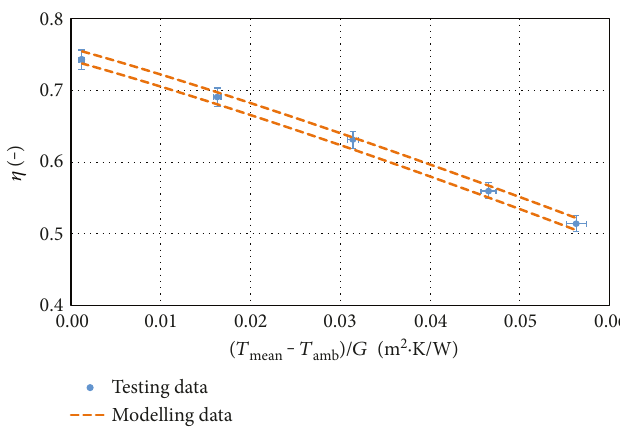
Figure 6: Mathematical model